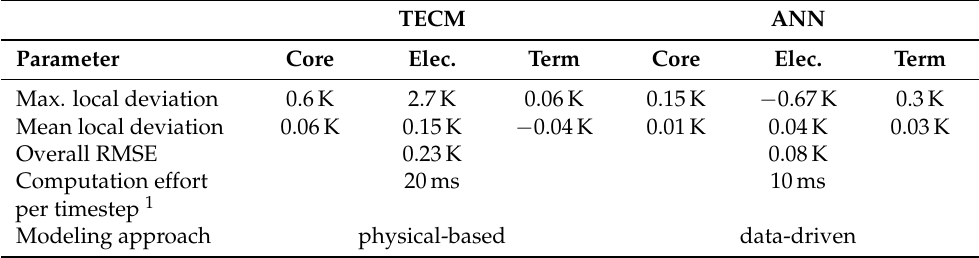
Figure 6. Transient temperature profiles of the TECM and the ANN and the related estimation deviation in comparison to the target data of the reference system. The locations of ( a ) the cell core, ( b ) the electronics and ( c ) the terminal. Table 3. Comparison of the TECM and the ANN model for the estimation scenario of Figure